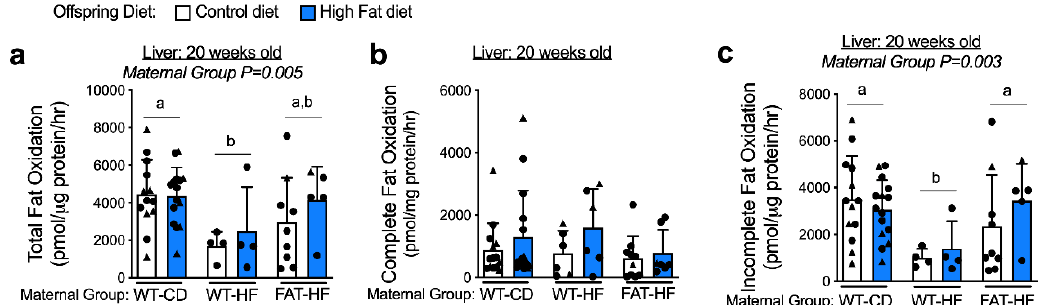
Figure 5. Maternal fat-1 transgene improves o ff spring liver fatty acid oxidation rates. Liver total fatty acid oxidation ( b ), complete fatty acid oxidation ( b ) and incomplete fatty acid oxidation ( c ) were measured at 20 wks in o ff spring of WT dams fed a control diet (WT-CD), or o ff spring of WT or fat-1 hemizygous dams fed a high-fat diet (WT-HF and FAT-HF, respectively) throughout pregnancy and lactation. All o ff spring were WT males (circles) and WT females (triangles) and were weaned to control or high-fat diet (post-weaning diet). Data are presented as mean ± SD. Di ff erent letters above bars denote statistically significant di ff erences between those bars at p < 0.05 significance level.